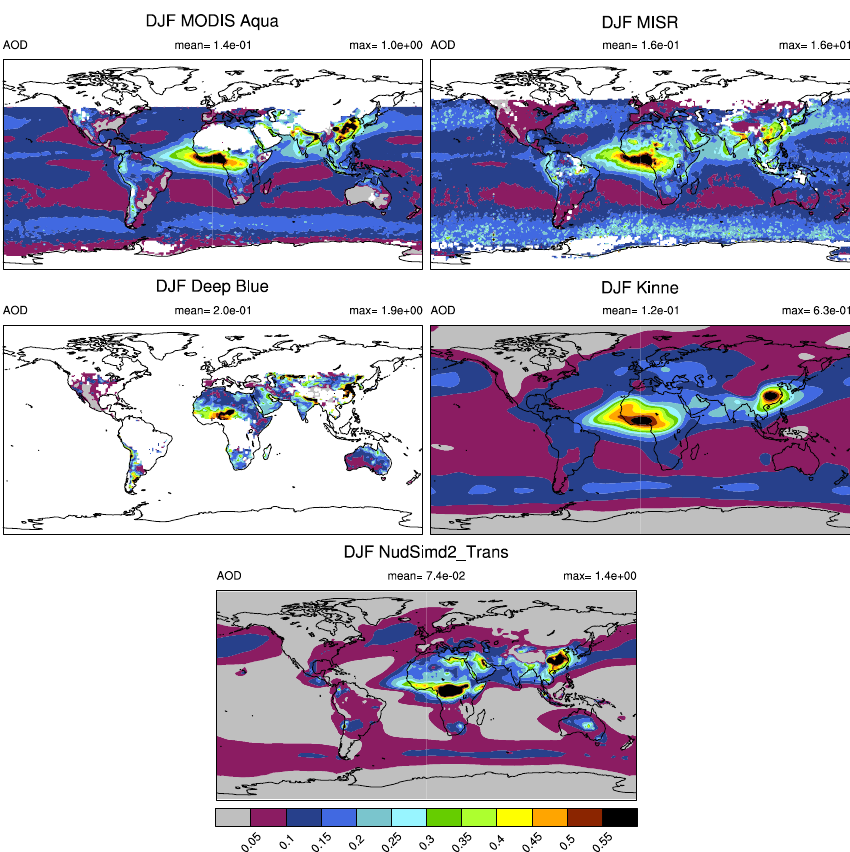
Figure 6. Mean DJF 2003–2012 total AOD for the MODIS Aqua, MISR, MODIS Deep-Blue and Kinne et al. (2013) data sets (from the top in the direction of reading), and from the NudSimd2_Trans simulation (third row).